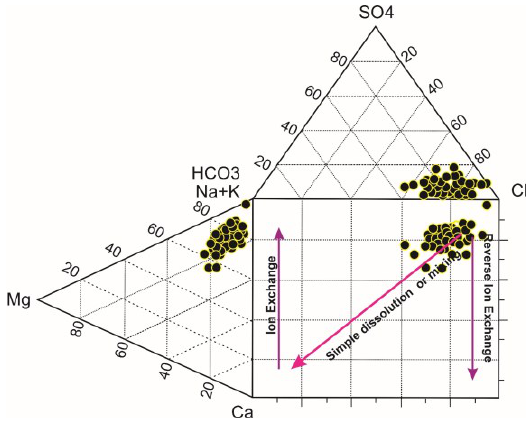
Figure 3. Durov plot explains water types and hydrochemical processes.